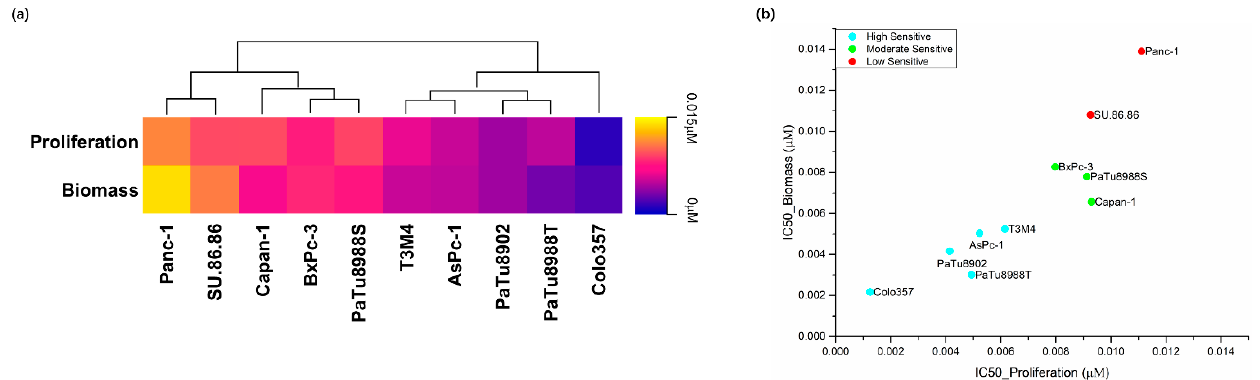
Figure 2. IC 50 values when assessing proliferation and cell biomass after 72 hours dinaciclib expo- sure in ten PDAC cell lines ( a ) as well as the classification of these cell lines by k-means++ (unsuper- vised machine learning algorithm) to a low (red), moderate (green), and high (blue) sensitivity group ( b